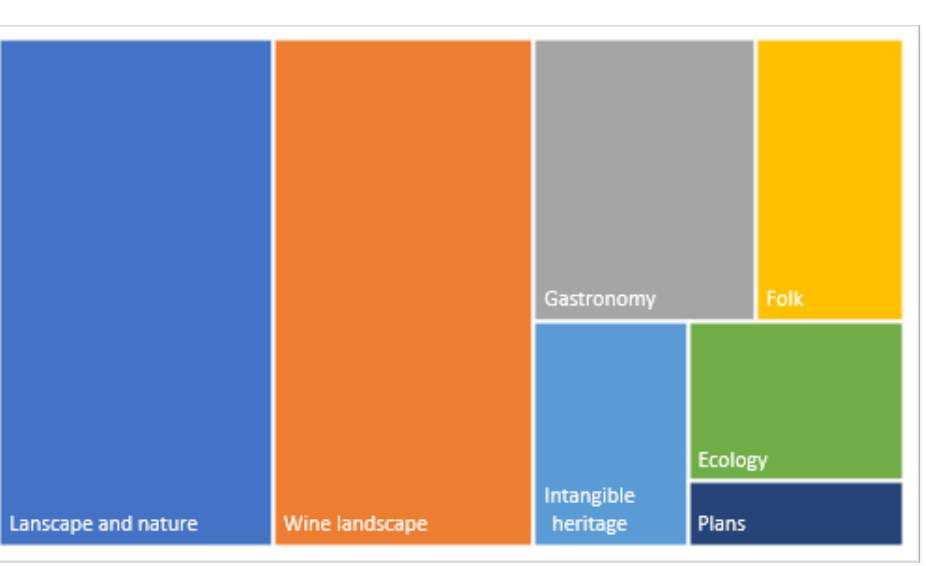
Figure 6. Tourist attractions of the Ribeira Sacra AO. Source: Own elaboration.